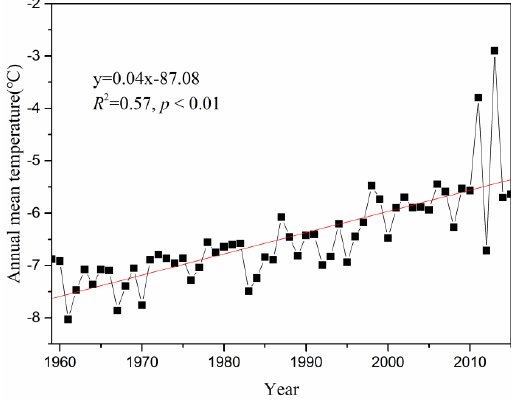
Figure 3. Reconstructed annual temperature at AWS1 during 1959–2015.